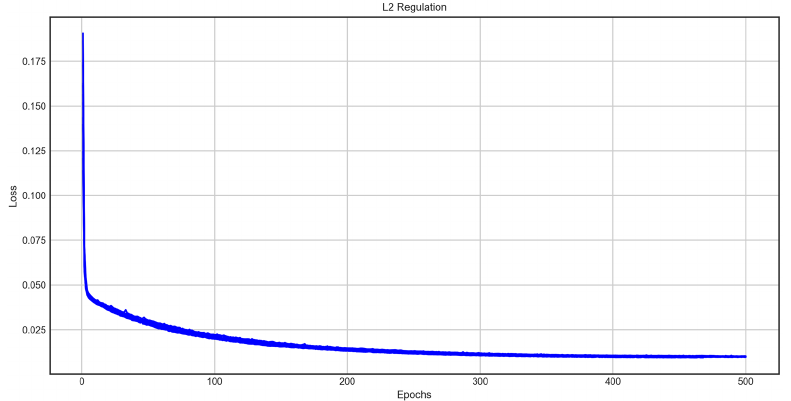
Figure 7. L2 Regulation Result (Case 2).